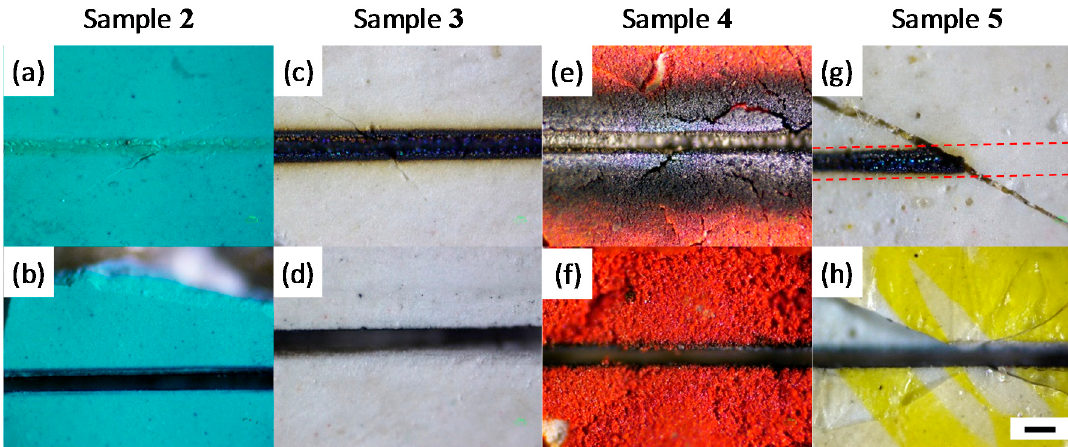
Figure 3. Optical images of trenches of samples 2 – 5 with the 60-mW CW laser (top row) and 2-mW (0.64-J/cm 2 ) femtosecond laser (bottom row) for sample 2 —panels ( a , b ); sample 3 —panels ( c , d ); sample 4 —panels ( e , f ); and sample 5 —panels ( g , h ). The red dashed lines on panel ( g ) shows the CW beam path. None of the CW measurements resulted in a cut, even with 30 times higher average power. Note that the panels ( g , h ) show different color, but are originated from the same paint in proximity. The black scale bar is 100 μ m.